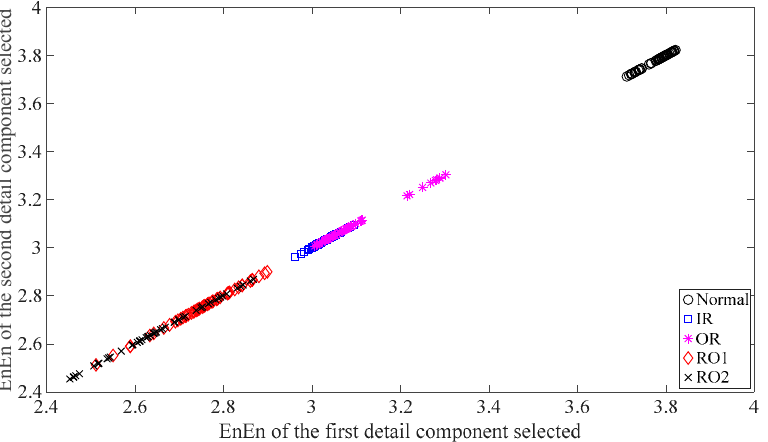
Figure 21. Two-dimensional EnEn of the two detail components most correlated with the original data for each of the five types of roller-bearing condition. In this case, the first detail components are selected for use.